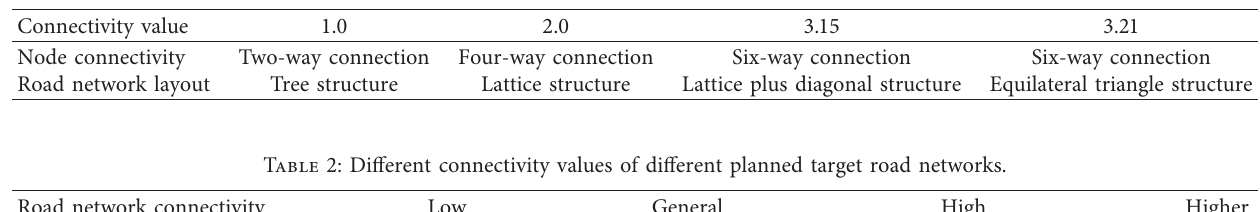
Table 1: The layout of the road network and nodes when the connectivity takes different values.